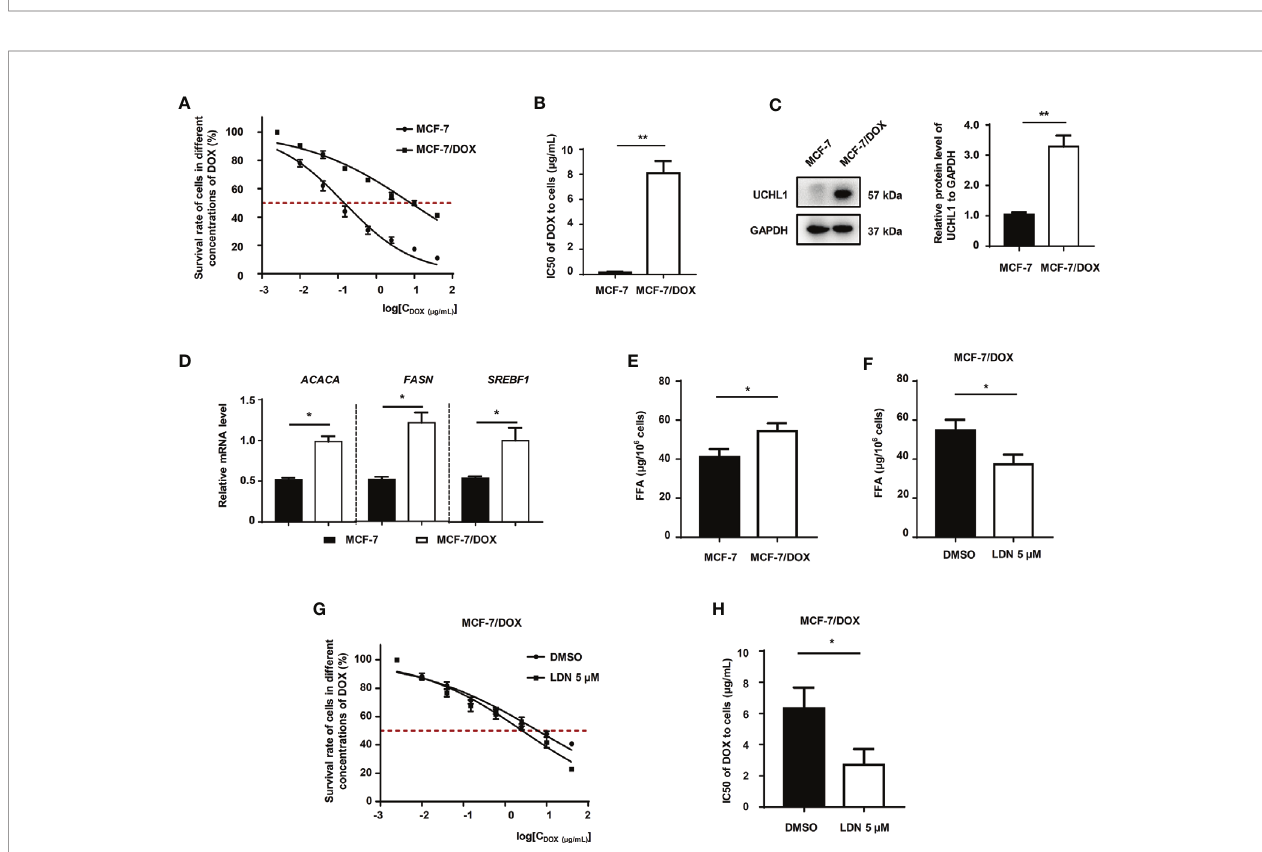
FIGURE 5 | The role of UCHL1 in fatty acid synthesis in BC cells. (A, B) Cell viability curves and IC50 values of MCF-7 and DOX-resistant MCF-7/DOX cells treated with DOX are shown (n = 3). Western blot analysis of UCHL1 (C) and real-time PCR analysis of lipogenesis-associated genes (D) in MCF-7 and MCF-7/DOX cells are shown and were analyzed by Mann-Whitney test (n = 3). The level of fatty acids in MCF-7 and MCF-7/DOX cells (E) and MCF-7/DOX cells in the presence of 5 m M LDN or DMSO (F) . (G, H) Cell viability curves and IC50 values of MCF-7/DOX cells treated with DOX in the presence of 5 m M LDN or DMSO are shown (n = 3). * p < 0.05, ** p <